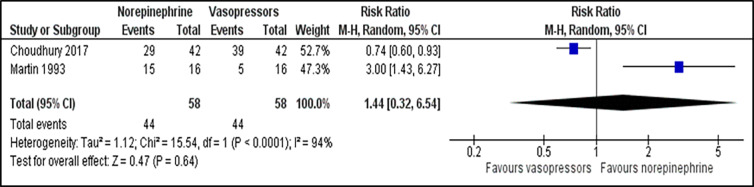
Comparison between norepinephrine and vasopressors for the outcome of the number of participants who achieved the target mean arterial pressure.M-H, Mantel-Haenszel method; CI, confidence interval.